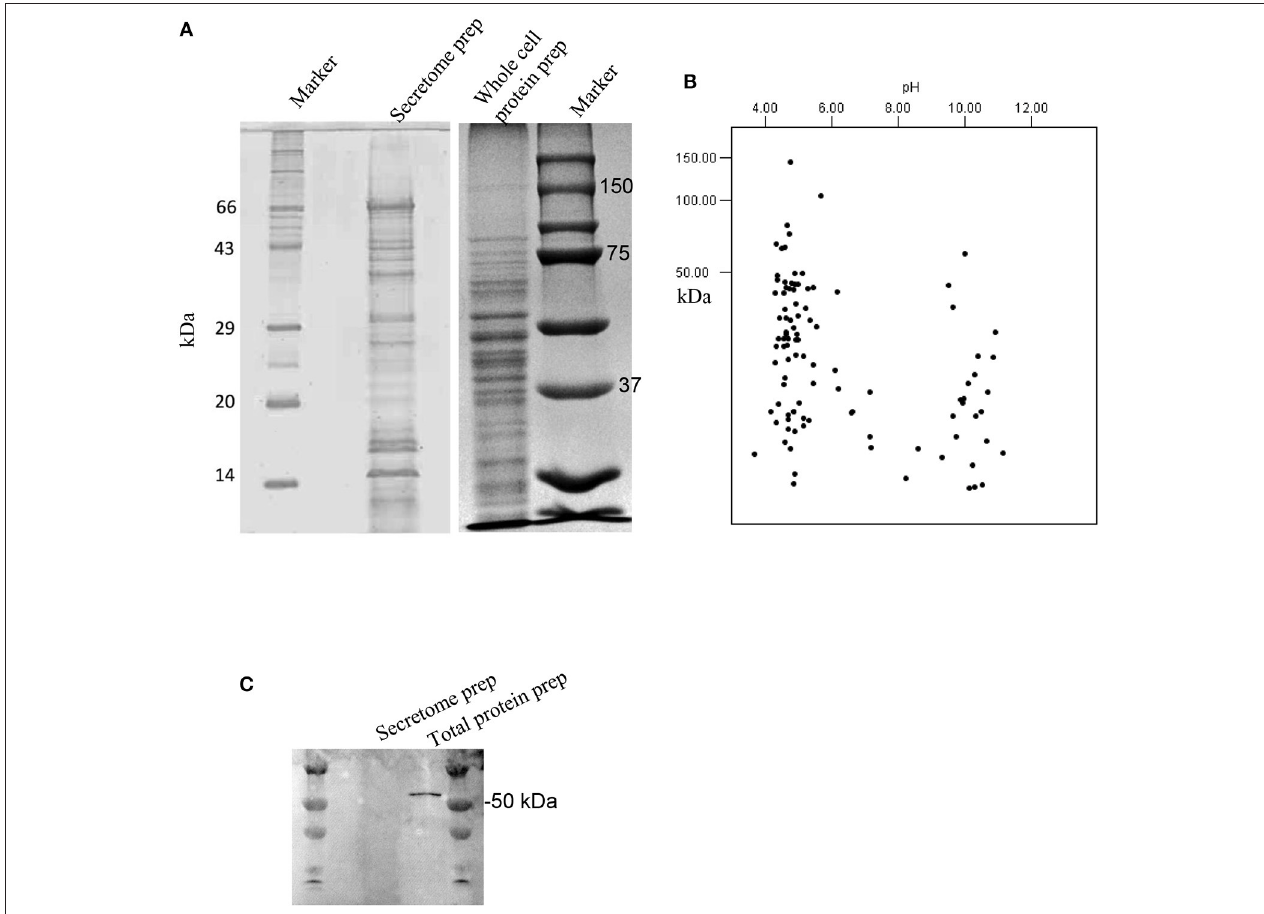
FIGURE 1 | Analysis of the secretome of G. adiacens . (A) SDS-PAGE gel showing protein bands from secretome preparation. (B) Protein sequences from LC-MS analysis of the secretome were analyzed by an in silico 2DE tool. (C) Western blot analysis showing the absence of the cytoplasmic marker protein FtsZ in the secretome